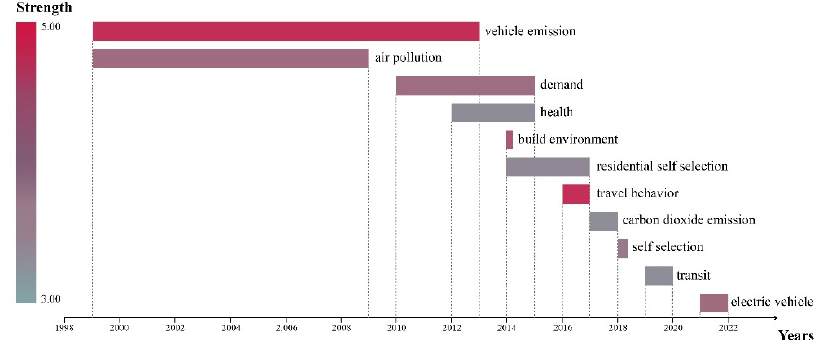
Figure 3. Top-11 keywords with the strongest citation bursts from WOS. The data for this figure were obtained from CiteSpace.